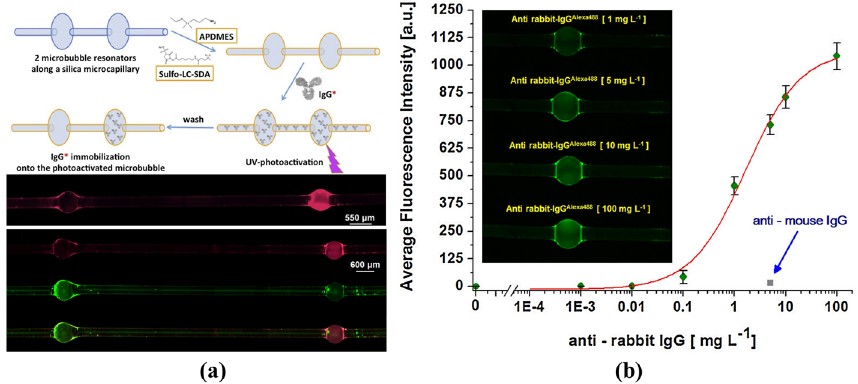
Figure 15. ( a , b ) Parallel biomolecule detection based on a photochemical activation method with microbubble resonators (reprinted with permission from [131], © Elsevier).